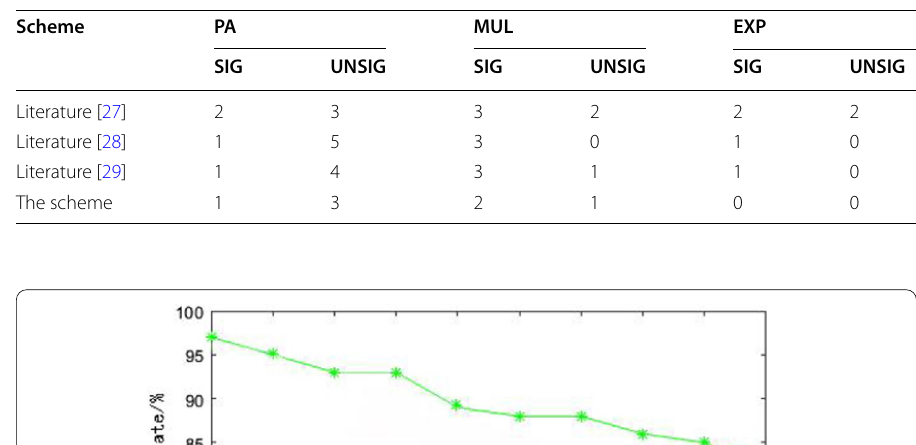
Table 2 Efficiency comparison